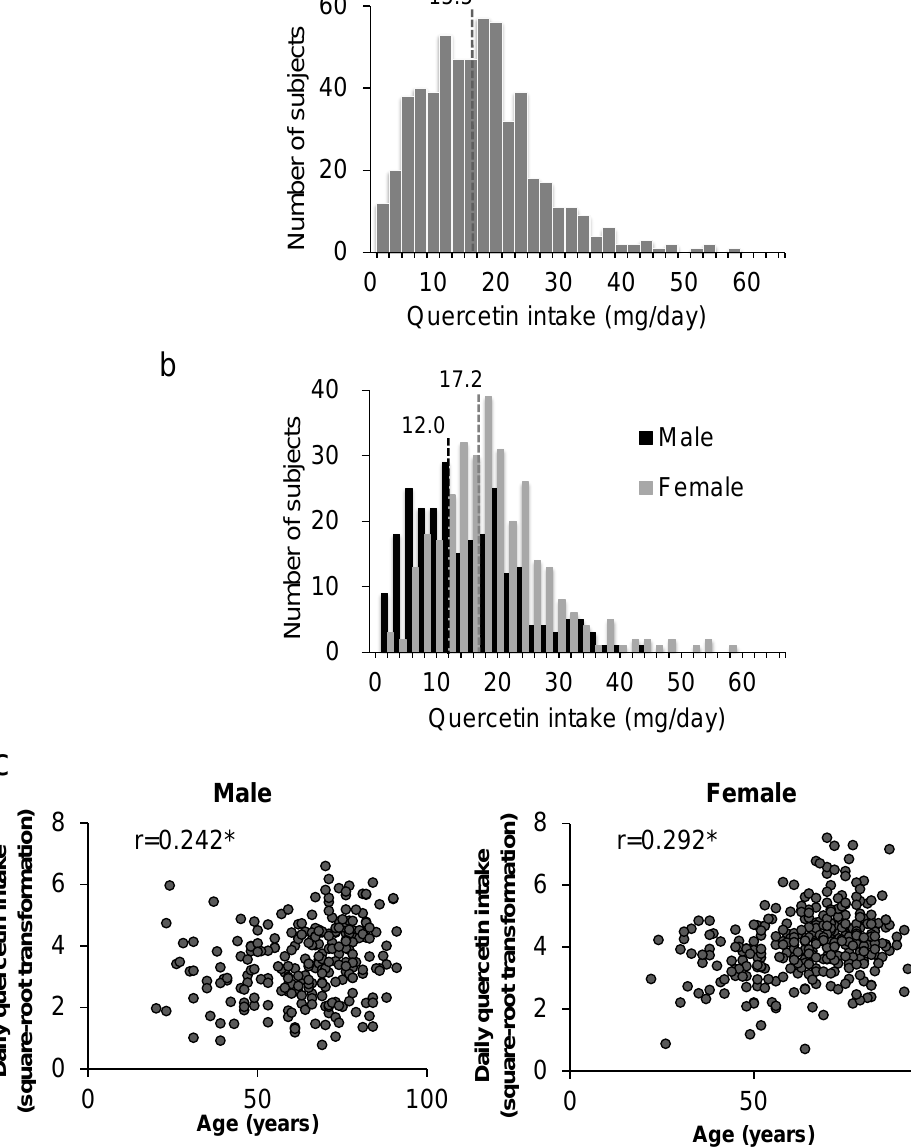
Figure 2. ( a ) Estimated daily quercetin intake by 570 residents of Sobetsu in Hokkaido using the FFQ during summer. ( b ) Estimated daily quercetin intakes by men and women using the FFQ during summer. Numbers in the figure show the median quercetin intakes by men and women. ( c ) Correlation between the daily quercetin intakes by men or women and their age. r, correlation coefficient; * p < 0.0001; Pearson correlation